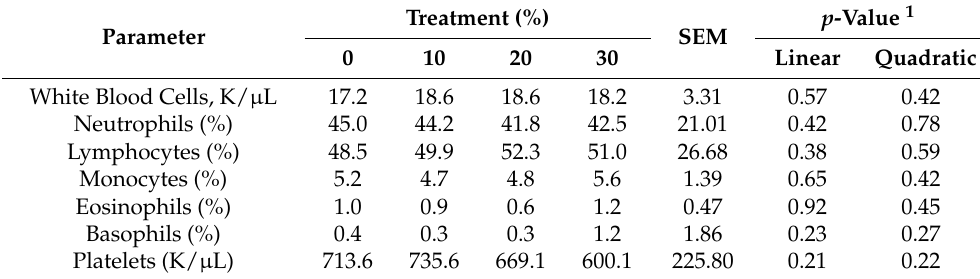
Table 5. White blood cell counts on day 60 of feeding period.